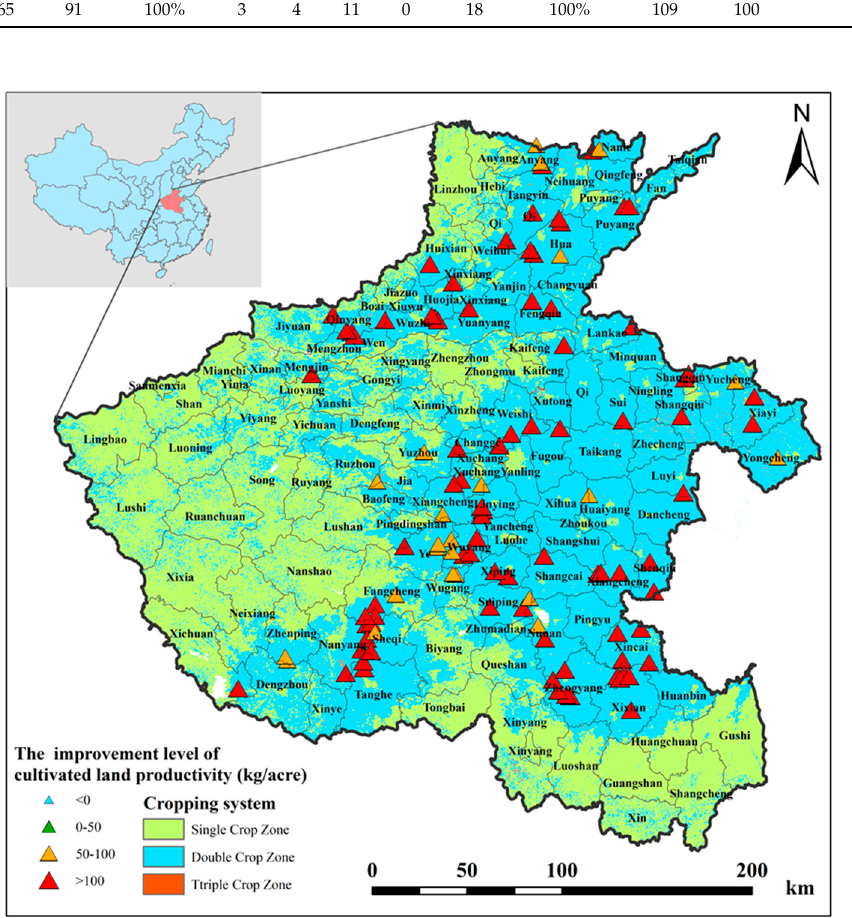
Figure 5. The improvement of cropland productivity level in the HSF construction project regions and the MLPF transformation project regions.